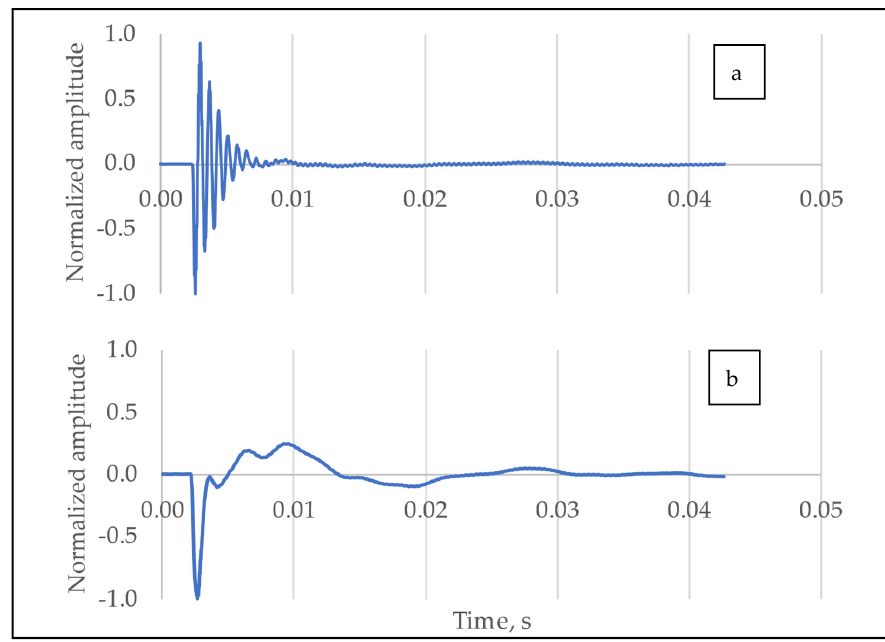
Figure 5. Normalized response signals of the eggs in NS ( a ) and EW ( b ) positions.